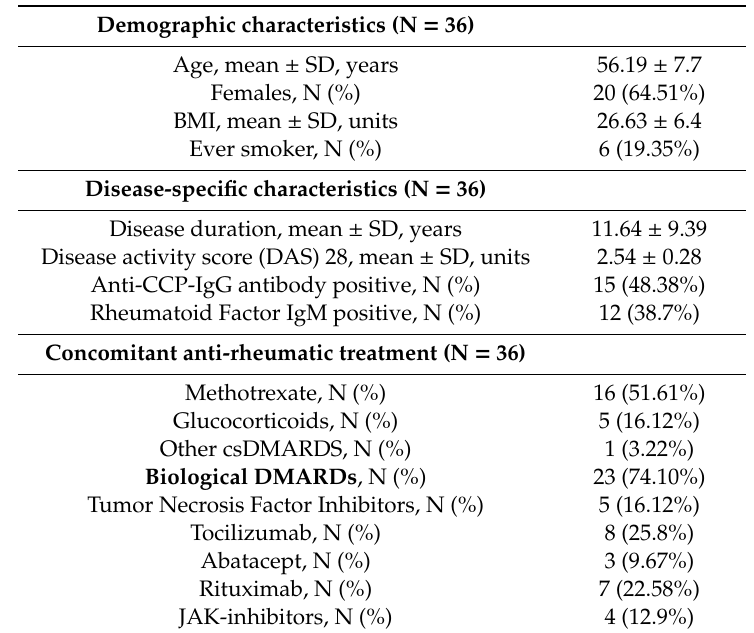
Table 1. Demographic data and current treatment of participating patients.